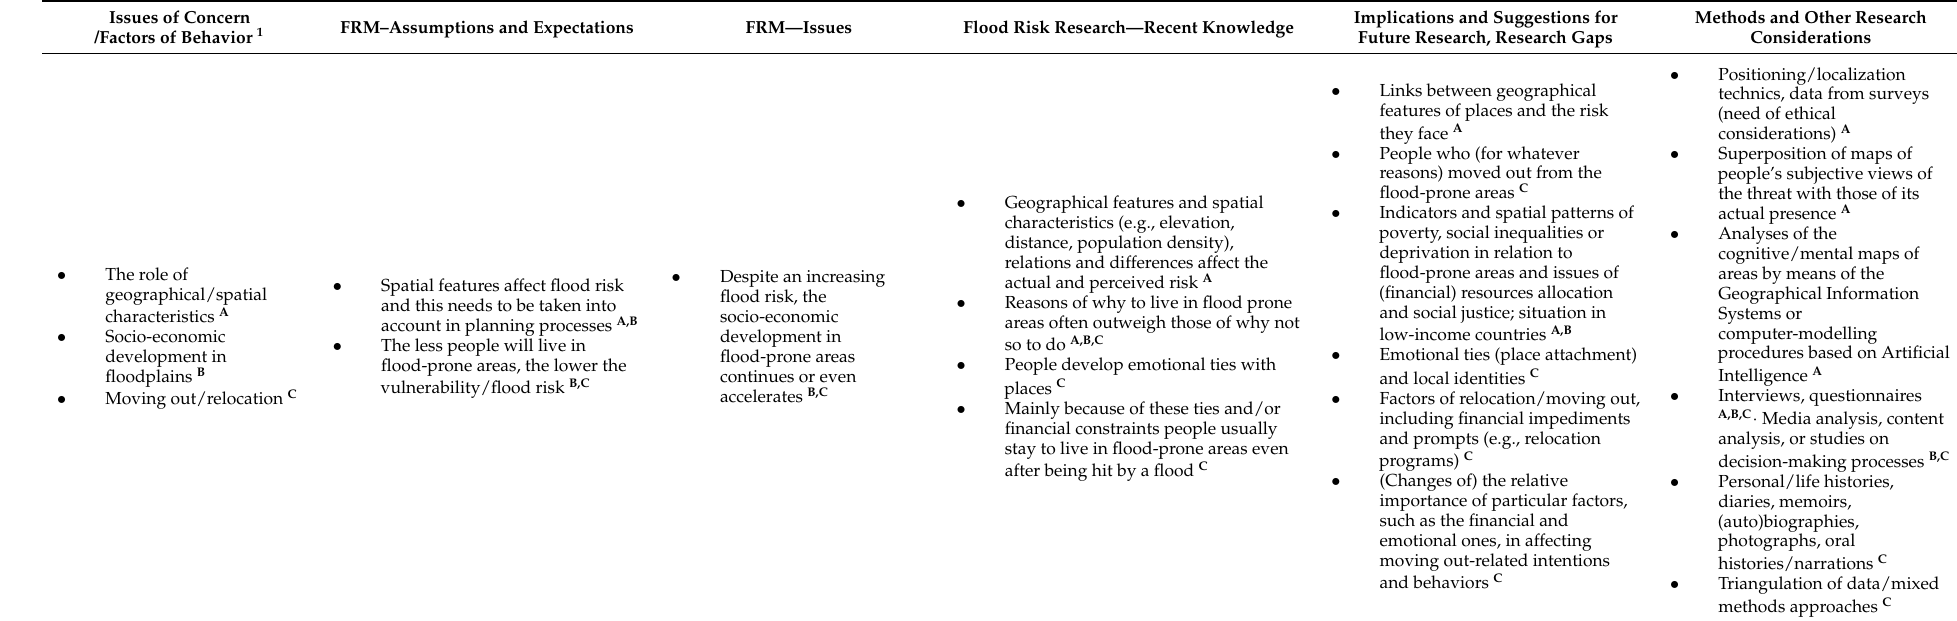
Table 6. Geography of risk–overview of findings, implications, and suggestions for future flood risk research